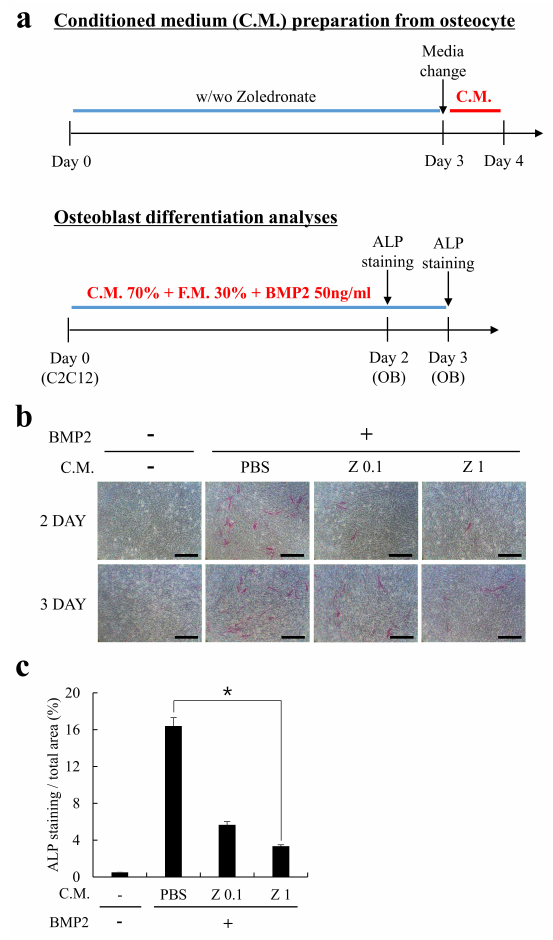
Figure 2. Conditioned medium (C.M.) from zoledronate-treated MLO-Y4 cells functionally reduced the osteoblastic differentiation of C2C12 cells. ( a ) A schematic diagram of C.M. preparation and osteoblastogenesis activity analyses. MLO-Y4 cells were cultured in the absence or presence of zoledronate (0.1 or 1 µ M) for 3 days, then the cultured medium was exchanged with fresh medium (without zoledronate) and the C.M. was collected for one more day. Separately, C2C12 cells were allowed to differentiate into osteoblasts in the presence of a mixed osteogenic medium (C.M. 70% + F.M. 30% + BMP2 50 ng/mL) for 2 or 3 days. F.M. stands for fresh medium; ( b ) C2C12 cells were cultured as in ( a ) and the osteogenic differentiation was assessed by alkaline phosphatase (ALP) staining on days 2 and 3. Bars, 200 µ m; ( c ) ALP stained images were quantified from experiments in panel ( b ). The quantitative data are presented as mean ± SD (* p <